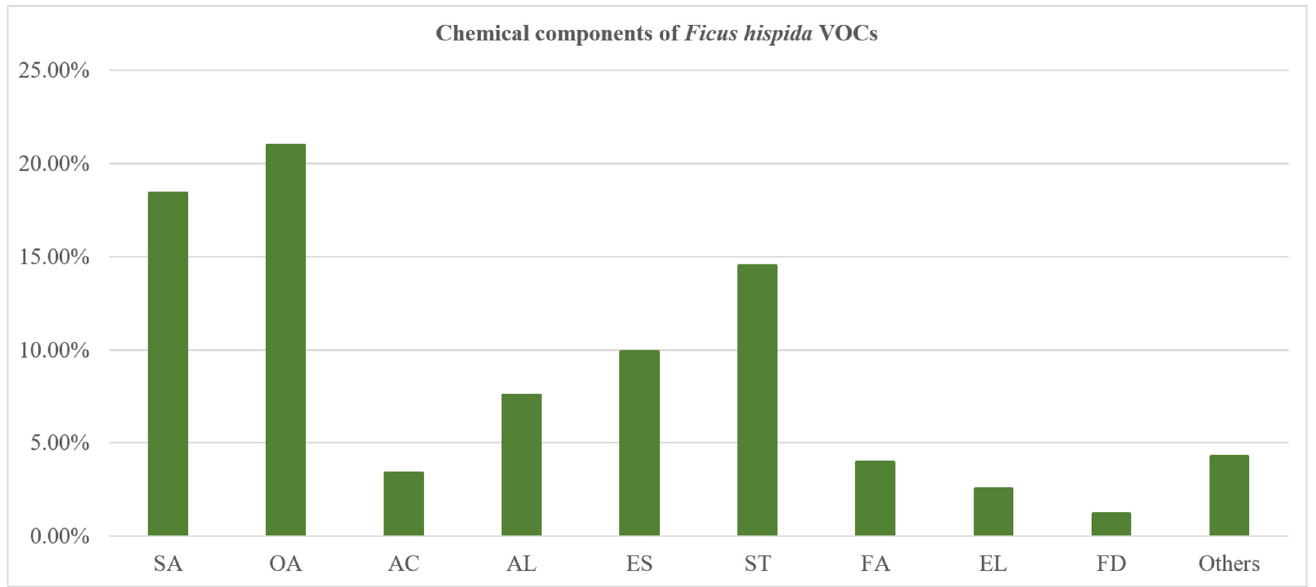
Figure 3. The percentage composition of chemical composition classes distilled from F. hispida L.f. SA: saturated aldehyde; OA: olefine aldehyde; AC: aromatic compounds; AL: alcohol; ES: ester; ST: sesquiterpenoids; FA: fatty acids; EL: enol; FD: furan derivatives. The distilled VOCs of 3 kg F. hispida leaves using a Clevenger-type apparatus permit- ted us to obtain EOs with a yield of 0.6 mL. In the previous study, volatiles of F. hispida from steam distillation was present in small quantities, about 20 μ L/kg fresh wt of F. his- pida plant material, which is much less than the yield in the present study [13]. The differ- ences between the volatile oils yield in this study and other studies reported in the litera- ture are probably due to the thermal treatment method (hydro-distillation and steam dis- tillation) [24]. In addition, studies conducted by Martinez-Nataren et al. showed that cli- matic and edaphic conditions have a significant effect on the VOCs yield, which suggests that each particular population presents specific microclimatic and edaphic conditions that influence the secondary metabolism of individual plants. In the present study, the chemical composition of F. hispida VOCs was rich in olefine aldehydes (20.96%) and saturated aldehydes (18.41%). However, the F. hispida composi- tion results of this study are not consistent with the previous study carried out in 2001 [13], which found that F. hispida VOCs were mainly composed of palmitic acid (30.74% to 27.80%) as the major compounds, followed by 9,12-octadecadienoic acid (9.31% to 5.43%). The chemical composition variations of F. hispida VOCs could also be attributed to several factors, such as the physiological and anatomical characteristics of the plant, the period of collection, the storage conditions, and the oil extraction techniques [25–27]. The plant bi- omass in the previous study was collected in the Xishuangbanna Tropical Botanical Gar- den, Yunnan, China, in 2001. However, in our research, the plant sample was collected in Lingshan County, Qinzhou city, Guangxi Province, China, in May 2022. Hence, consider- able geographic variation in the VOCs composition was observed across bioclimatic re- gions, as well as among populations and individuals. 3.2. Antioxidant Activity The method for evaluating antioxidant activity is still evolving. In the present study, the antioxidant activities of F. hispida VOCs obtained after thermal treatment were deter- mined using three different methods: DPPH, ABTS, and FRAP. Table 2 shows the antiox- idant tests of the VOCs obtained from the F. hispida biomass.